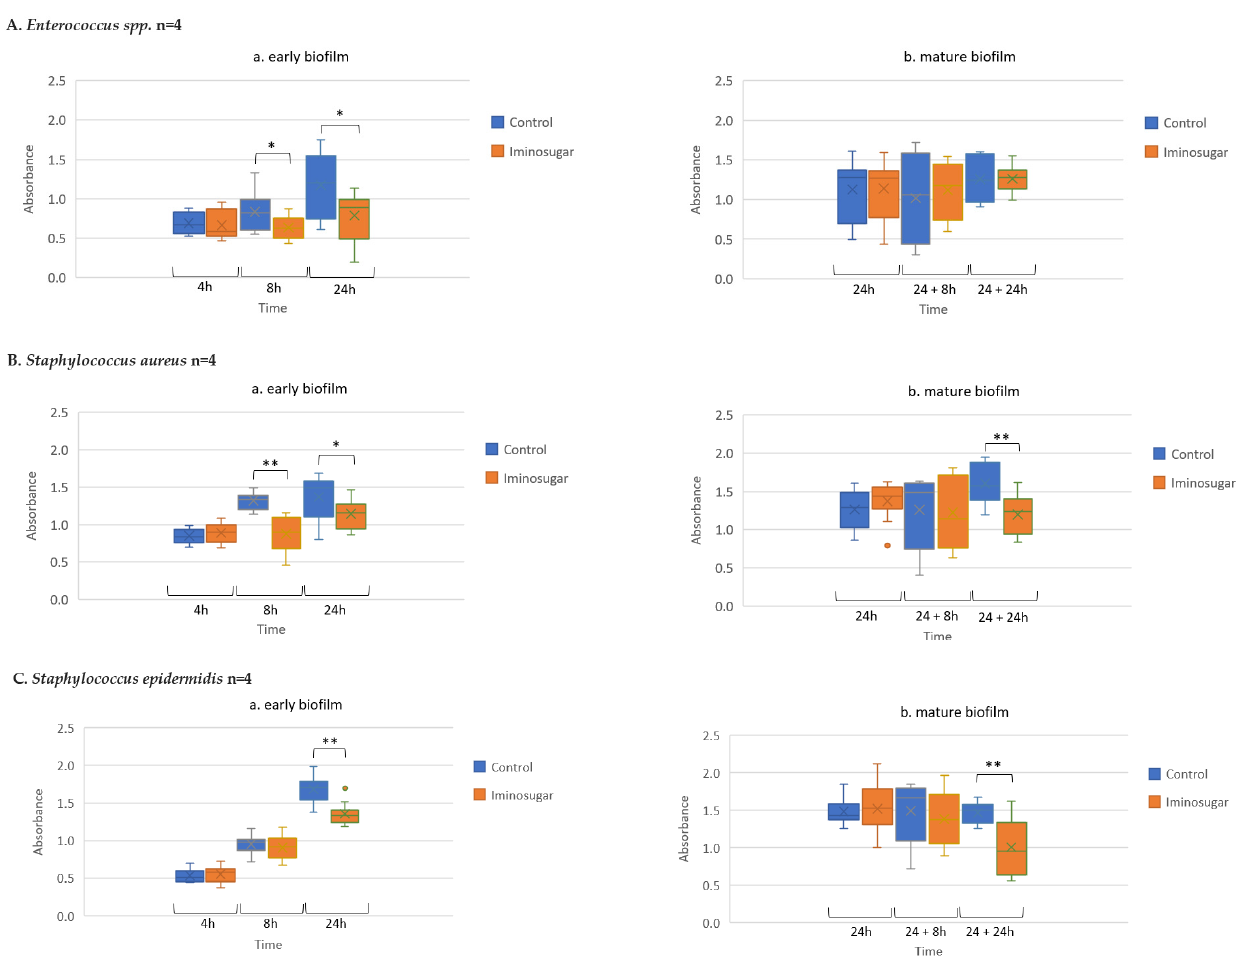
Figure 3. Effect of iminosugar PDIA on biofilm production by selected Gram-negative non- fermentive rods. ( A ) Pseudomonas aeruginosa and ( B ) Acinetobacter spp. in ( a ) early biofilm and ( b ) mature biofilm. n refers to the number of strains. The figure represents biofilm absorbance readings for all strains belonging to a given species at a given time (measurements for each strain were performed in triplicates). Biofilm production expressed as absorbance ( λ = 492 nm) after Congo red staining at different time points. ** p < 0.01.